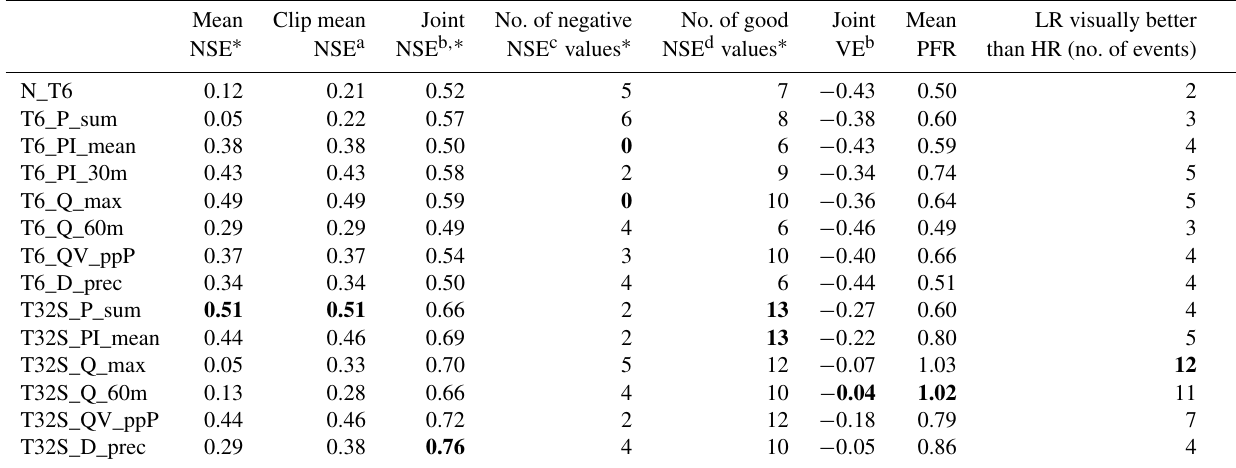
Table 7. Summarized validation performance (over 19 events) for the low-resolution model. Bold font indicates the best value in each column. The columns marked with ∗ are not discussed in the text, but they are shown here for completeness and comparability with Table 6. Mean Clip